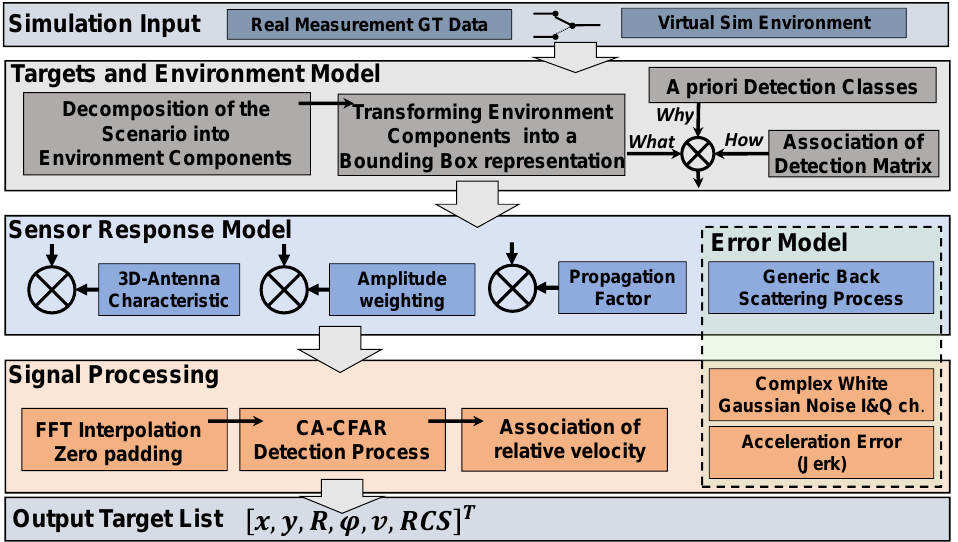
Figure 2. Modular structure of the radar sensor